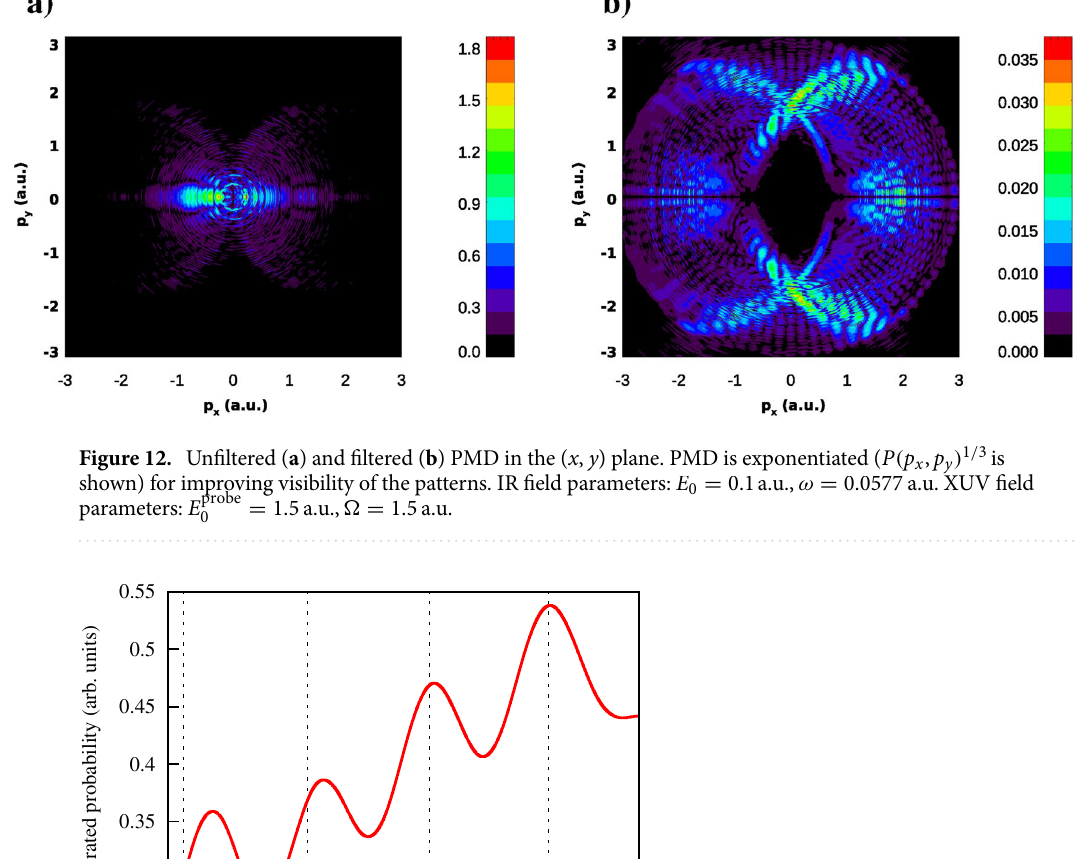
0.1 a.u., ω 0.0577 a.u. XUV field = =